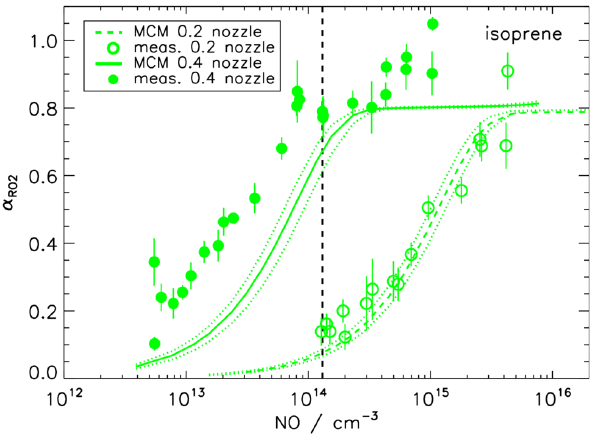
Fig. 5. Same as Fig. 4, but for RO 2 radicals produced by isoprene and